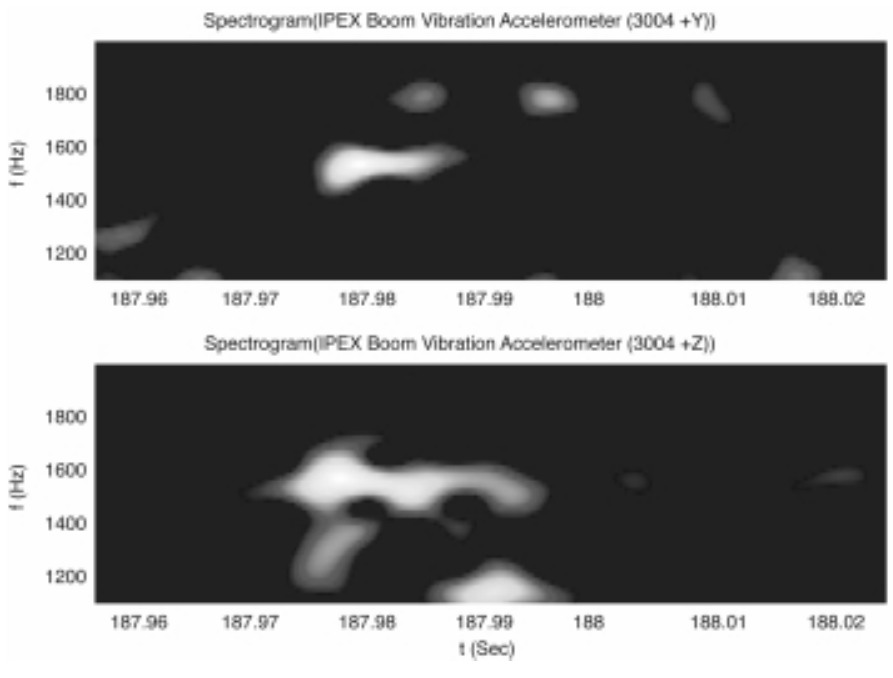
Fig. A10. Event 3 Node 3004 Spectrogram.